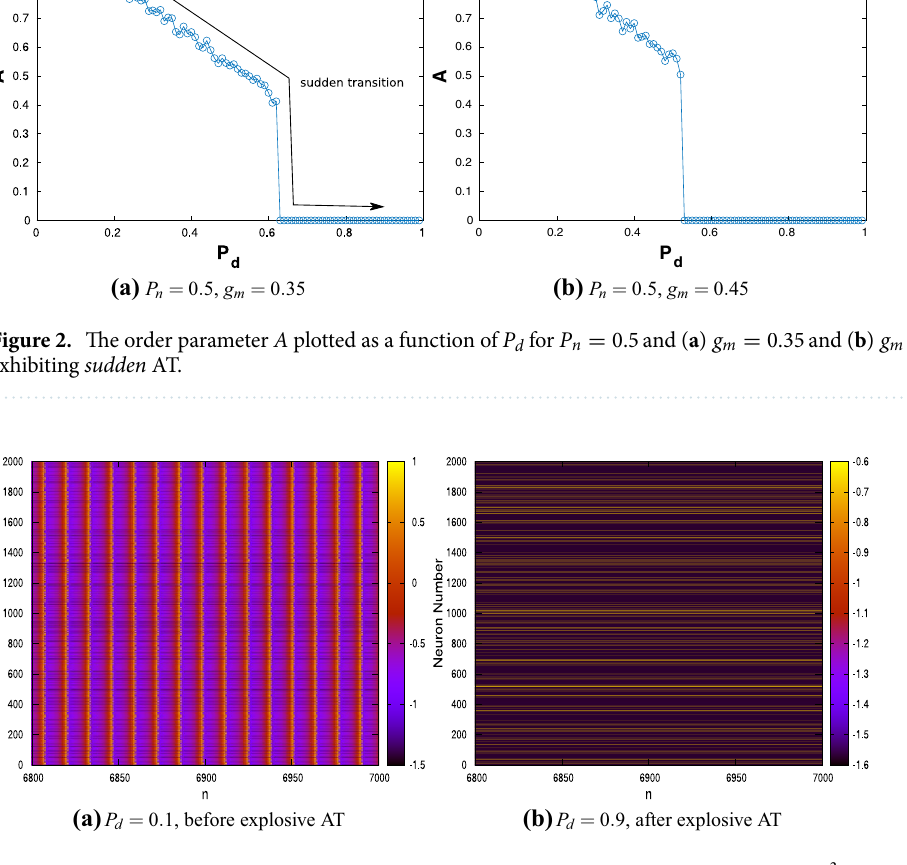
Figure 3. Time history diagrams showing the dynamical behaviour of each of the N = 2 × 10 3 neurons (plotted on the ordinate) with time/iterate (plotted on the abscissa for n = 6800 to n = 7000 ); ( a ) the dynamics for the system before AT ( P n = 0.5 , g m = 0.35 and P d = 0.1 ); ( b ) the dynamics for the system after AT ( P n = 0.5 , g m = 0.35 and P d = 0.9